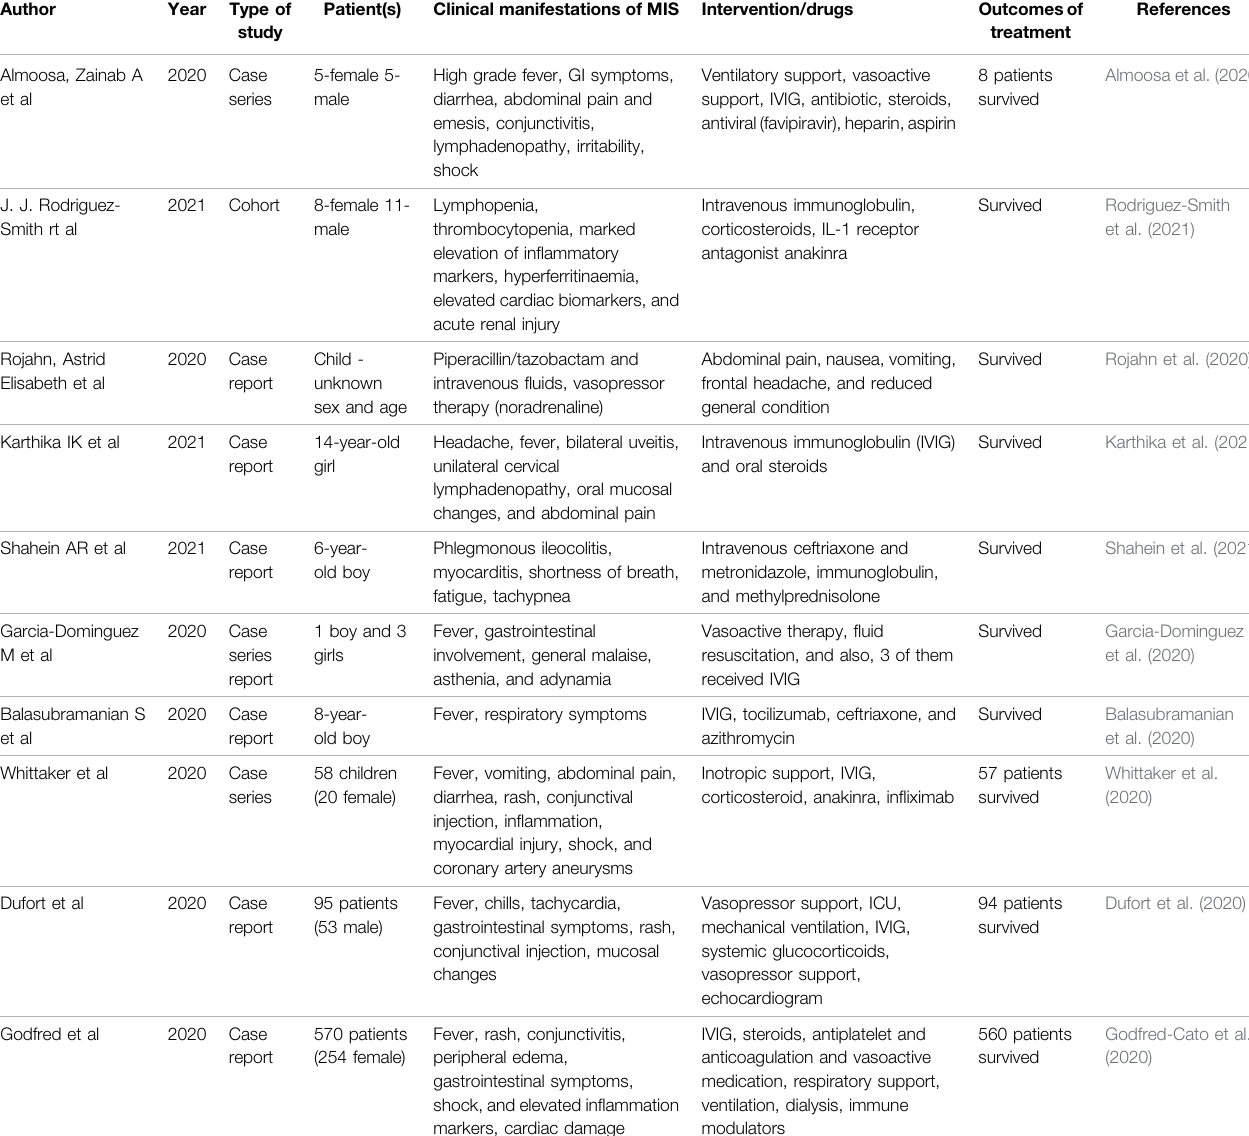
TABLE 1 | ( Continued ) Summary of studies on the therapeutic options for multi-system in fl ammatory syndrome following SARS-CoV2